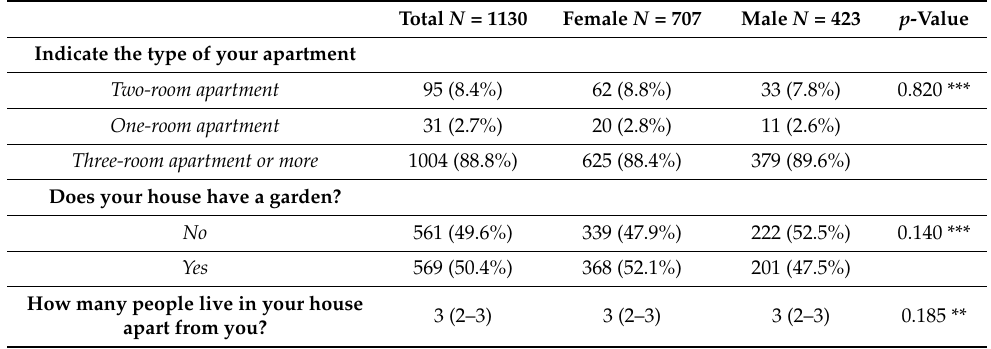
Table 2. Characteristics of dwelling of the university population and stratification by gender.